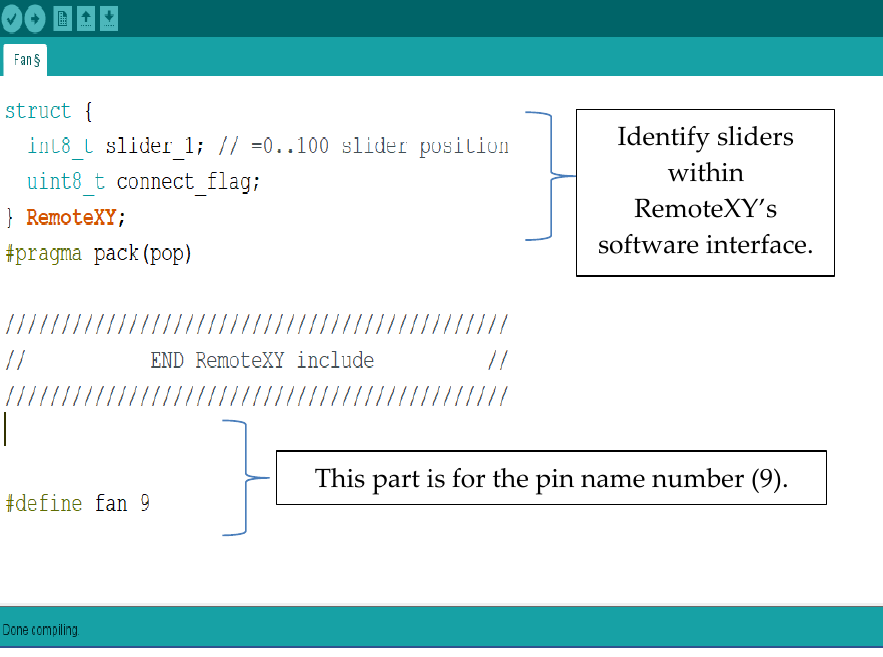
Figure A3. The first part of the executed code used to control the fan speed.